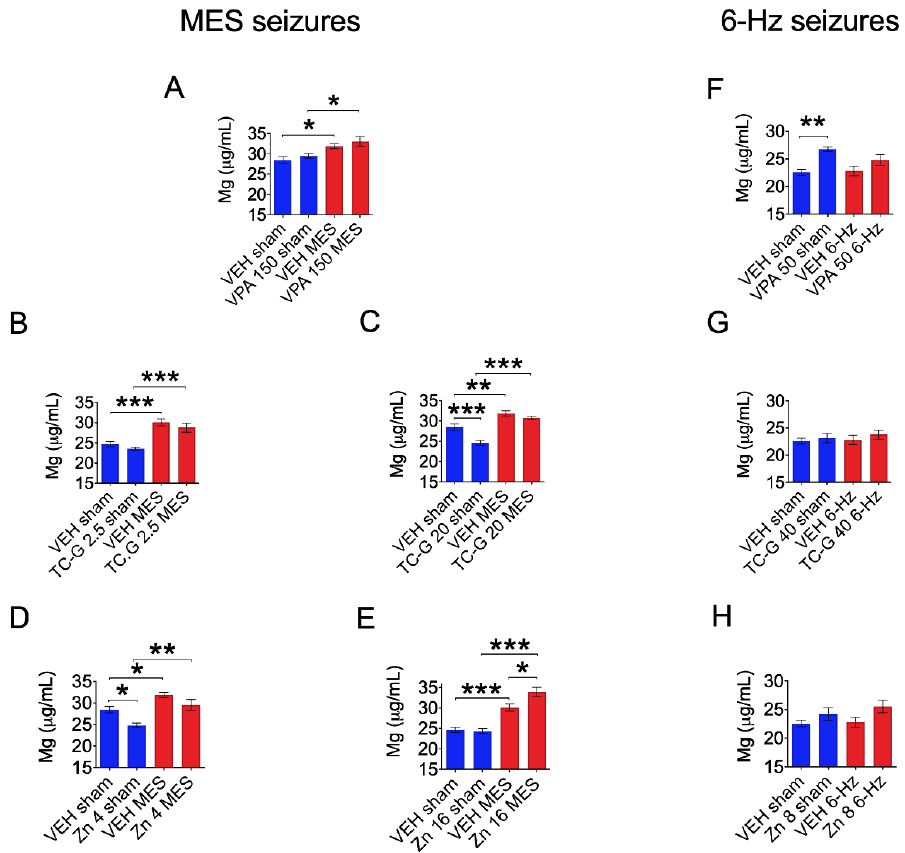
Figure 1. The effects of acute treatment with valproic acid (VPA) ( A , F ), TC-G 1008 ( B , C , G ), or ZnCl 2 ( D , E , H ) and maximal electroshock (MES) seizures ( A – E ) or the 6 Hz ( F – H ) seizures on total serum magnesium concentrations. Drugs (the doses are shown on the abscissas) or vehicle (VEH) (1% Tween 80 in physiological saline) were administered i.p., 30 min before MES or 6 Hz seizures, in Swiss albino mice. Non-stimulated (sham) animals received the same doses of drugs or VEH, but they did not receive the electrical stimulus. Total serum magnesium concentration was analyzed by inductively coupled plasma optical emission spectrometry (ICP-OES) at ca. 3 min after MES or 6 Hz seizures. Data are expressed as means ± SEM. Data were analyzed by two-way ANOVA and Tukey’s multiple comparison test. Statistical details: ( A ) Interaction [F(1,36) = 0.0111, p = 0.9168], VPA 150 [F(1,36) = 1.835, p = 0.1840], MES [F(1,36) = 18.48, p = 0.0001]; n = 10 in each group ( B ) Interaction [F(1,30) = 0.0144, p = 0.9051], TC-G 1008 2.5 [F(1,30) = 2.611, p = 0.1166], MES [F(1,30) = 50.66, p < 0.0001]; n = 10 VEH sham, n = 8 VEH MES, n = 9 TC-G 1008 2.5 sham, n = 7 TC-G 1008 2.5